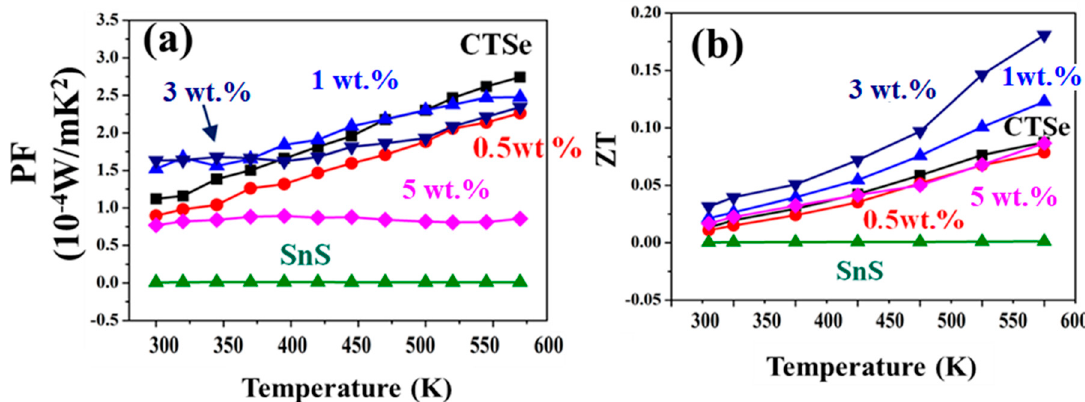
Figure 8. ( a ) Power factor and ( b ) ZT of CTSe, SnS, and Cu 2 SnSe 3 -SnS composites in the temperature range from 300 to 570 K.